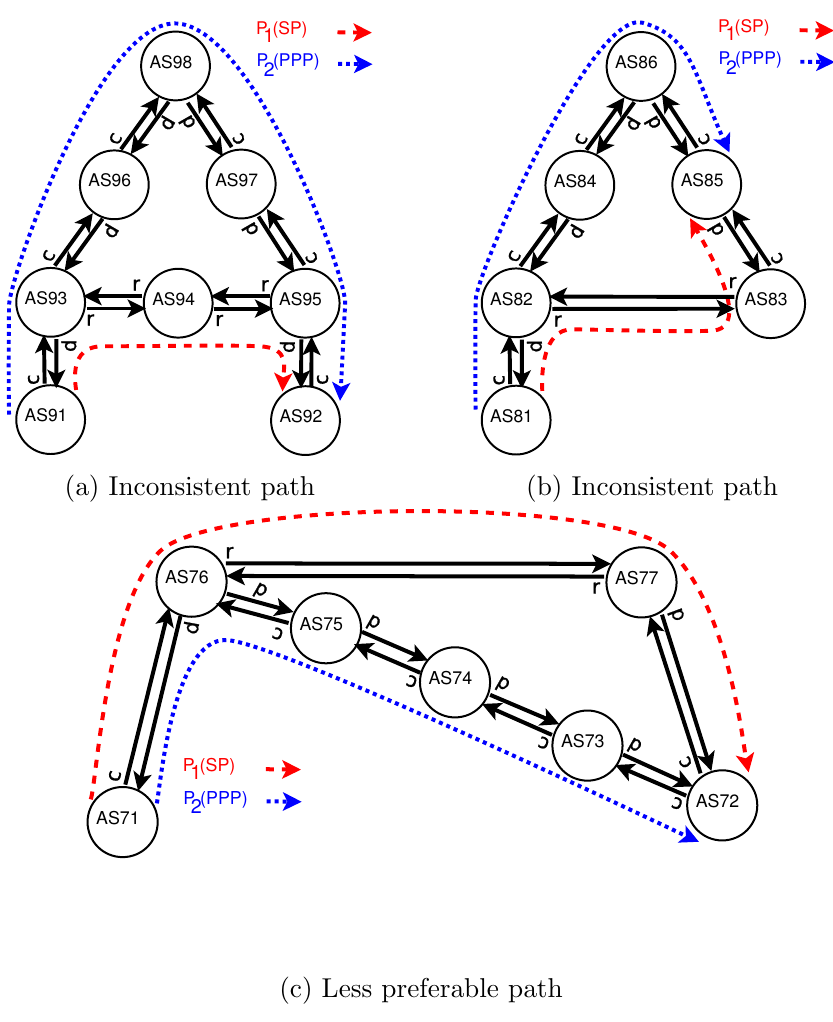
Figure 8: Policy Preferred Paths (PPP) algorithm compared to the Shortest Paths (SP)